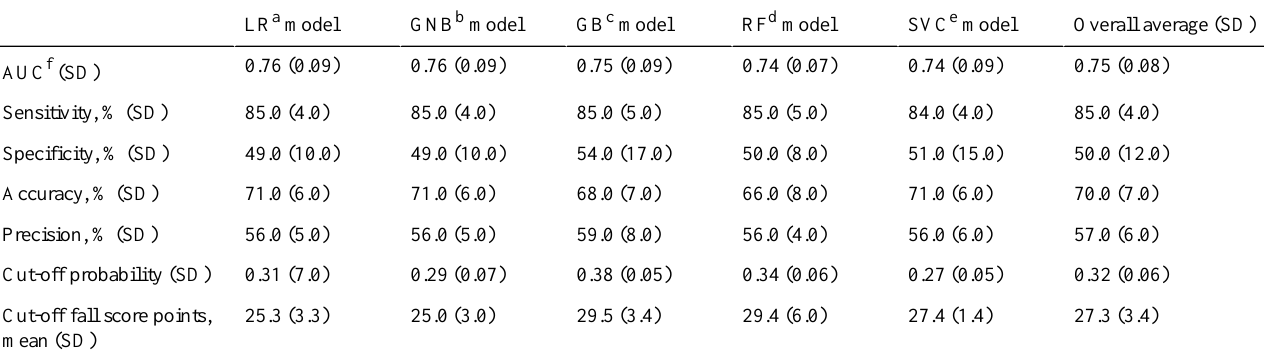
Table 1. Results of the k-fold stratified cross-validation study (k=8).